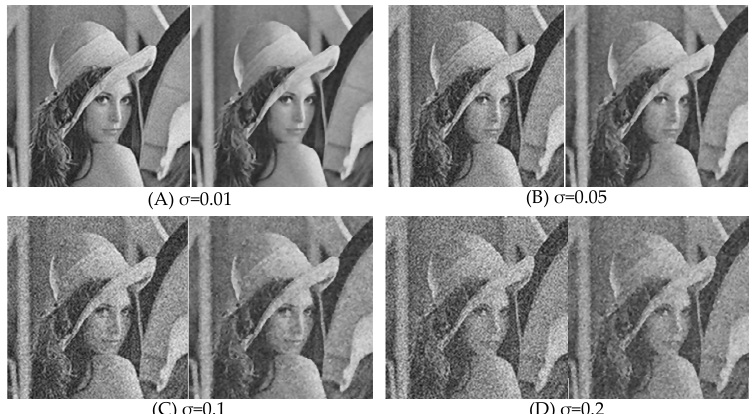
Figure 12. The effect of the bilateral filter: the left is no BF method and right is proposed method. (A) Lena of noise σ = 0.01; (B) Lena of noise σ = 0.05; (C) Lena of noise σ = 0.1; (D) Lena of noise σ = 0.2.